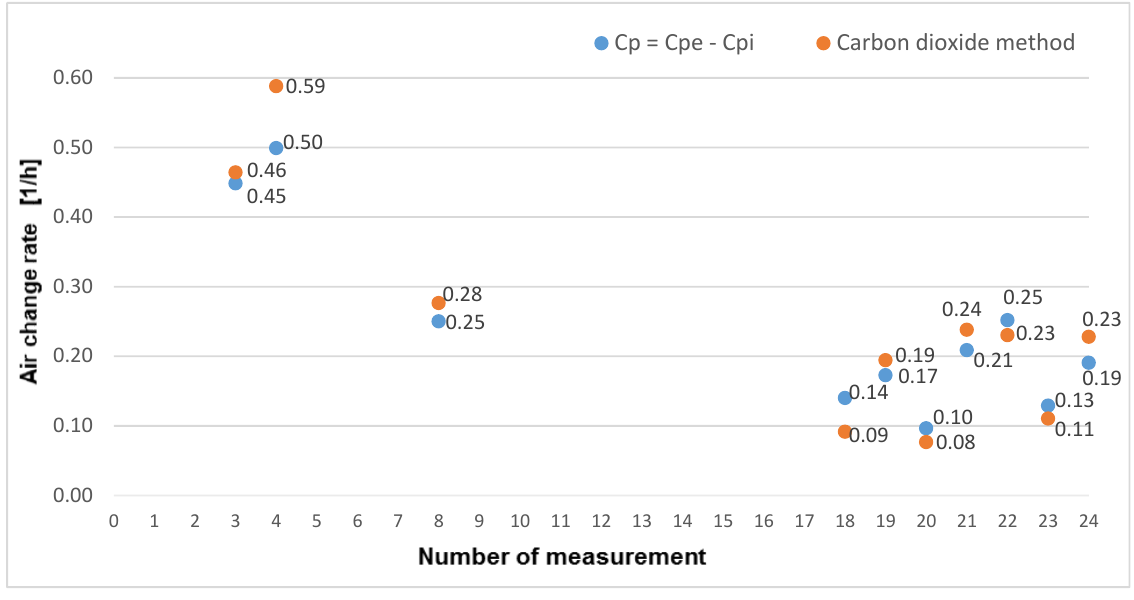
Figure 13. Calculated differences and percentage differences in air change rate determined by different methods.